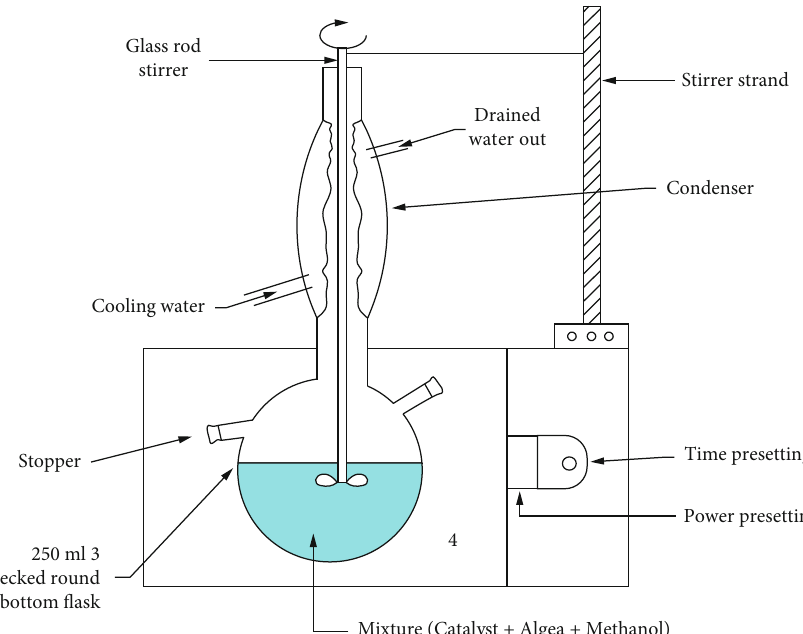
Figure 1: Batch transesteri fi cation with microwave